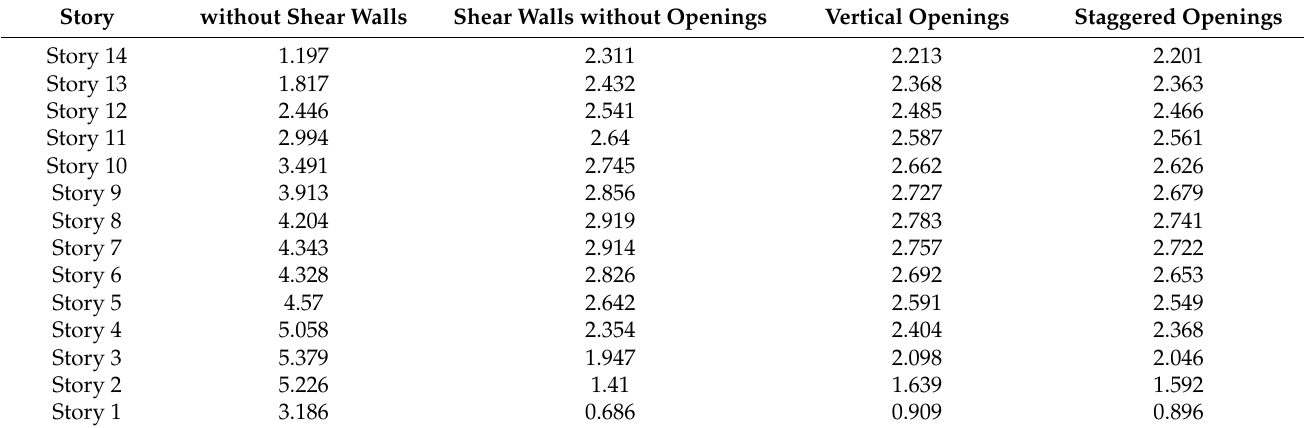
Table 15. Comparison of the story drift, time history analysis, Y-direction (mm).